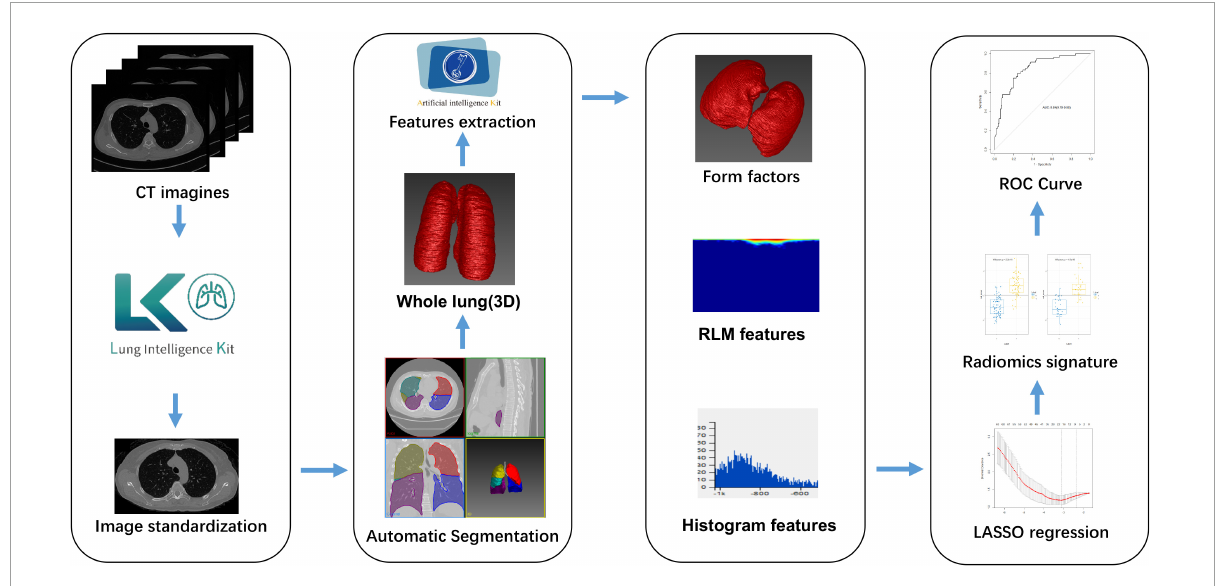
FIGURE1 Flowchart showing how the radiomic signature was developed. CT, computed tomography; LASSO, least absolute shrinkage and selection operator; RLM, run length matrix; ROC, receiver-operator